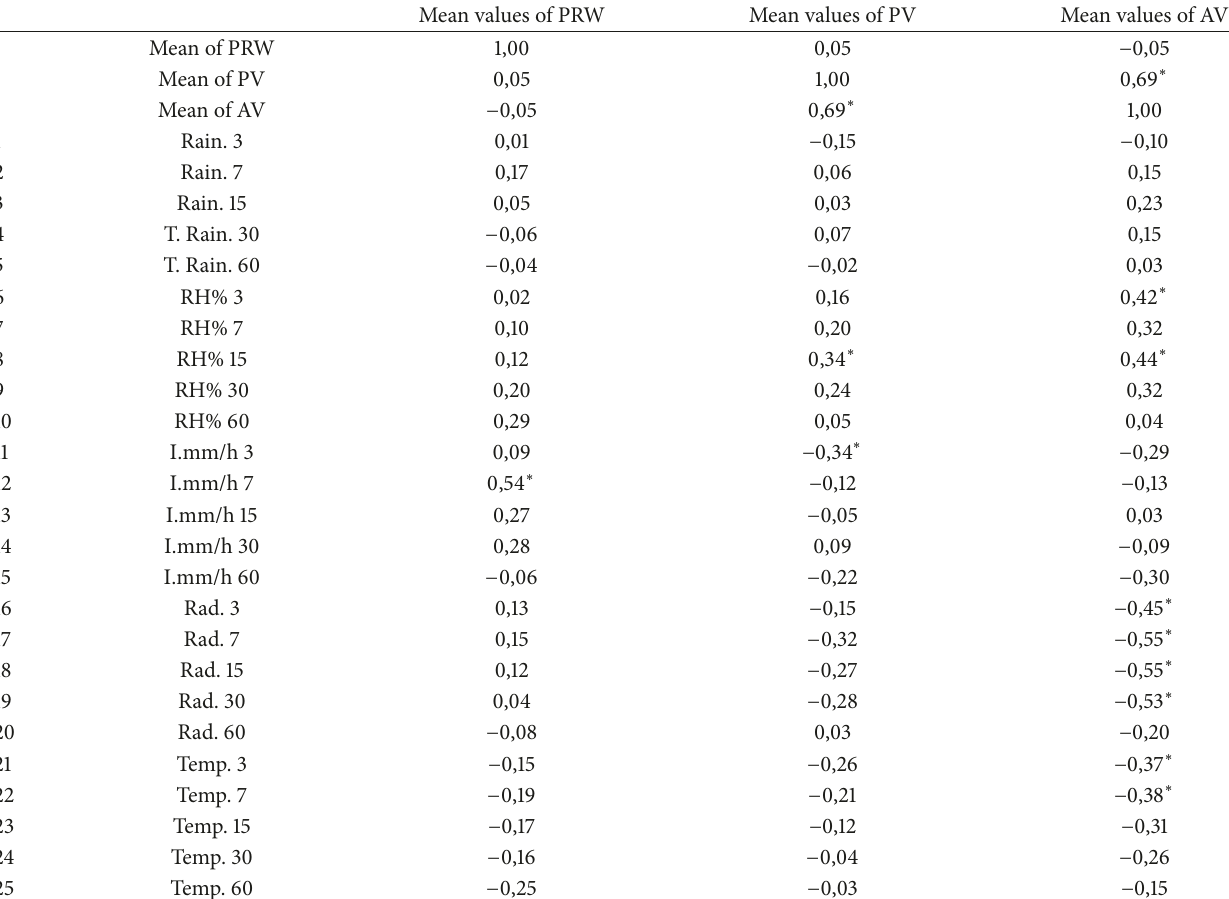
Table 9: Correlation matrix of the number of PRW, PV, and AV and weather variables in the second period (1999-2000). Mean values of PRW Mean values of PV Mean values of